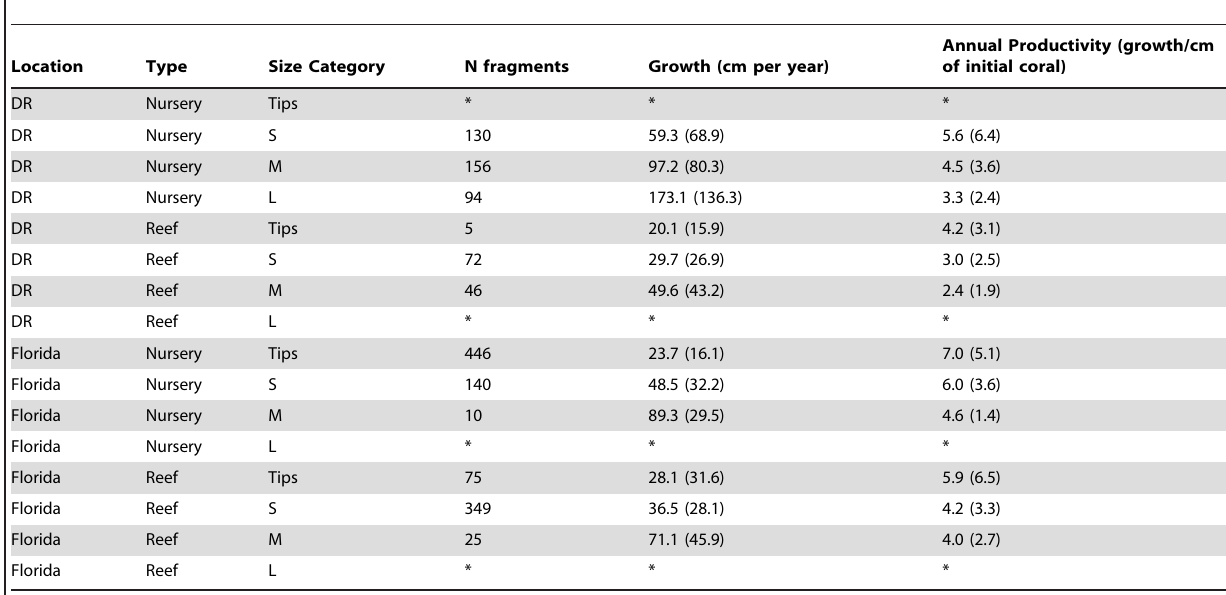
Table 1. Annual growth and productivity ( 6 S.D.) of staghorn fragments in Florida and the DR.